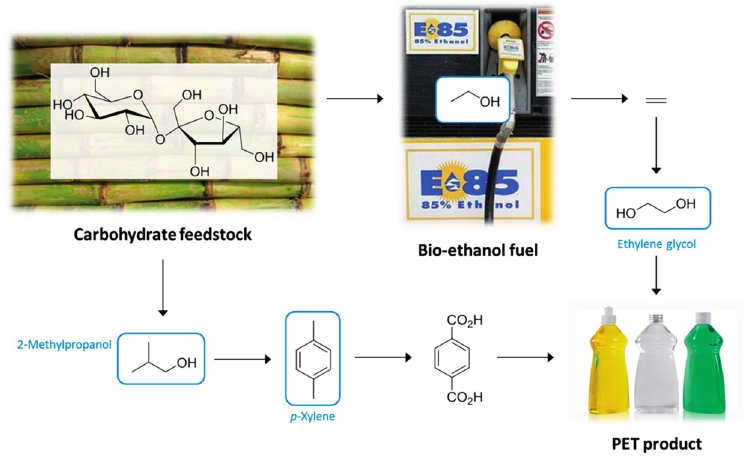
Figure 1. The interconnecting biofuel and bioplastic manufacturing industries and the solvent intermediates that result. Solvents are ringed in